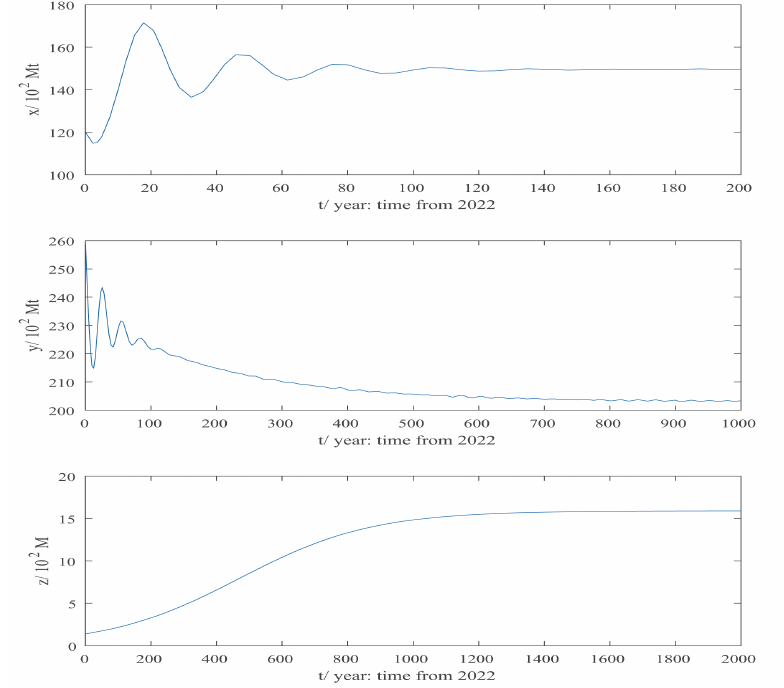
Figure 6. Equilibrium point E ∗ of system (3) is locally asymptotically stable when τ = 5 under the second group of